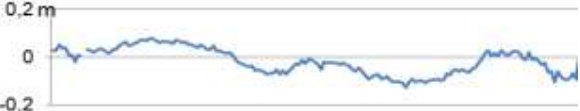
Figure 6. Averaged WV-2 y-parallax over 8 km in north-south A WorldView-4 (WV-4) stereo pair, covering 8km times 21km,